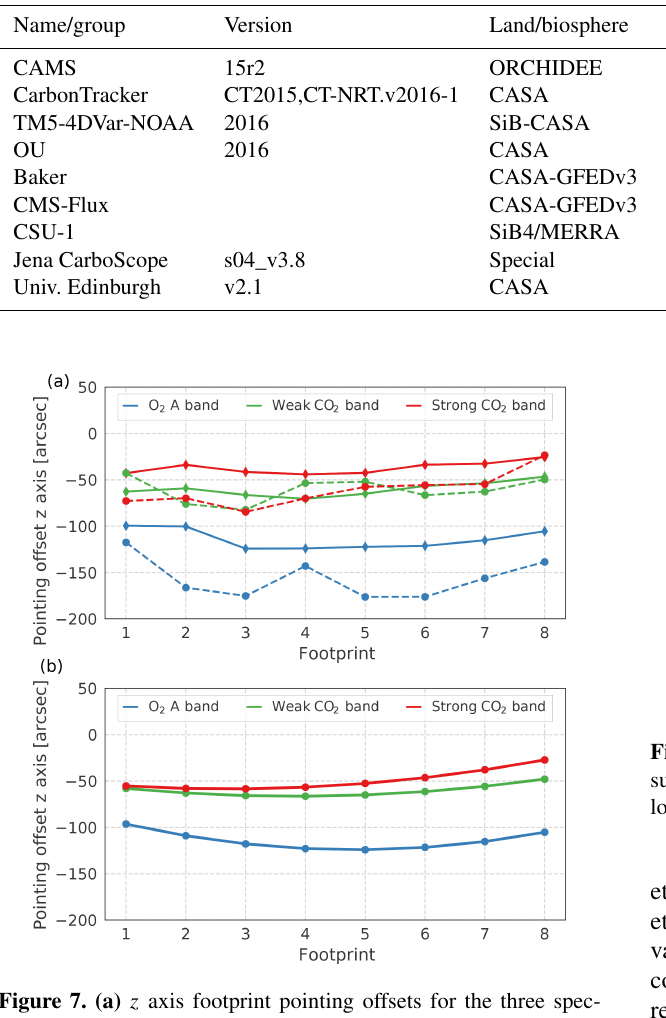
Figure 7. (a) z axis footprint pointing offsets for the three spec- tral bands for the Death Valley National Park (solid) and Atacama Desert (dashed) and (b) z axis footprint pointing offsets used in the OCO-2 v9 geometric calibration algorithm.